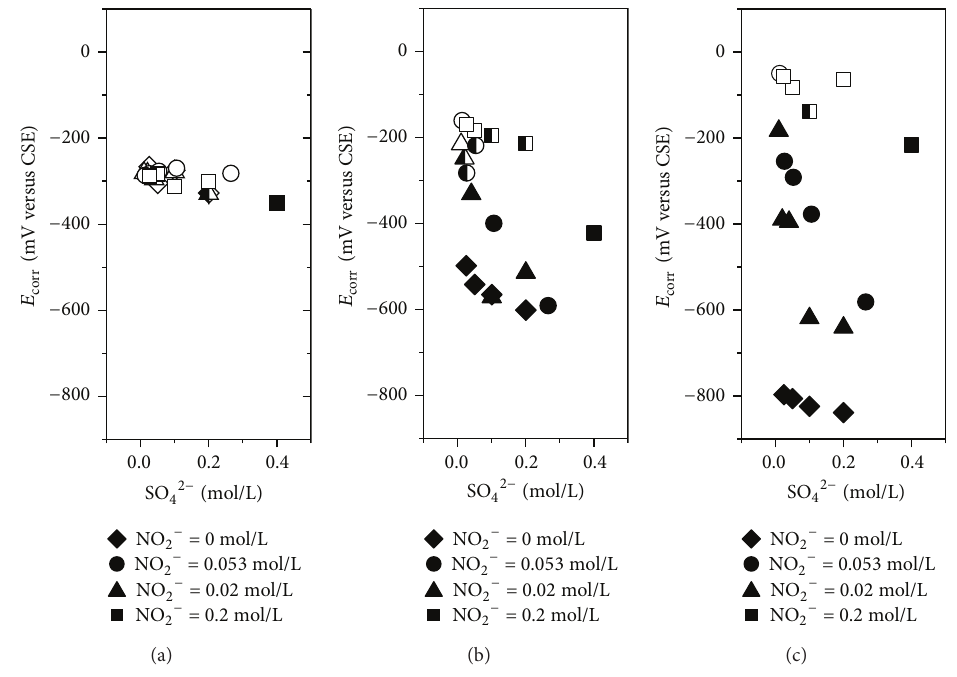
Figure 5: Effect of NO 2− and pH on 𝐸